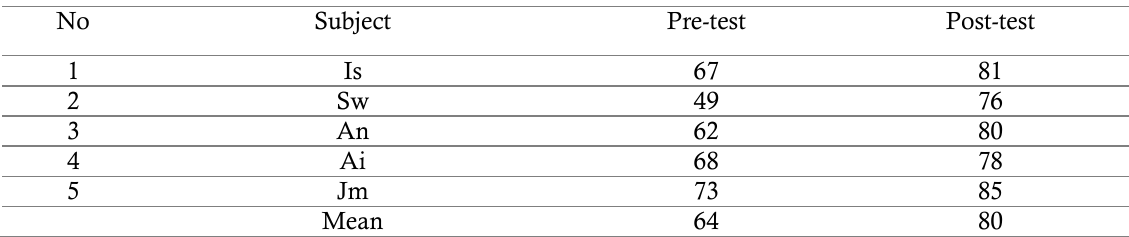
Tabel 1 : Result of career adaptability pre-test and